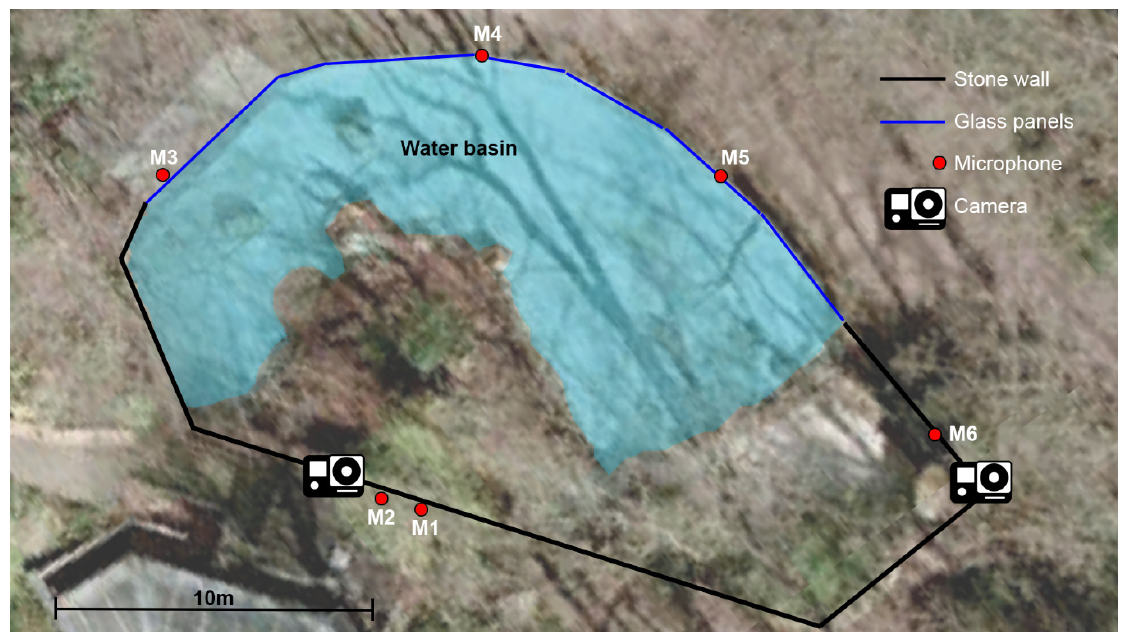
Figure 3. Design of the giant otter enclosure with positions of microphones and cameras. The satellite view from Google Earth was used for the map (Image © 2021 AeroWest).